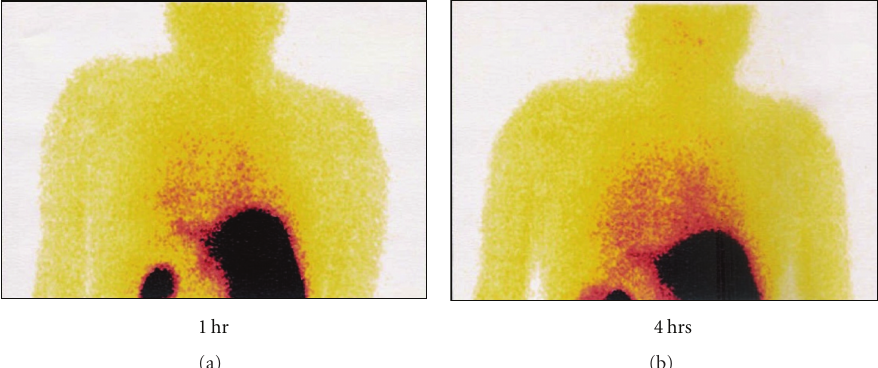
Figure 4: Scintigrams of patient, showing preferential localization of radiotracer in the lung lesion after 1 hour and 4 hours postinjection of 370MBq of 99m